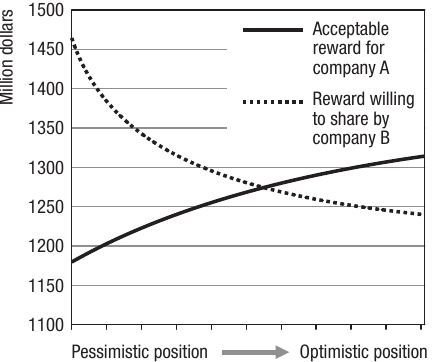
Optimistic positionPessimistic Fig. 5. Estimated individual bargaining Fig. 6. Estimated acceptable total rewards positions and rewards in different bargaining positions